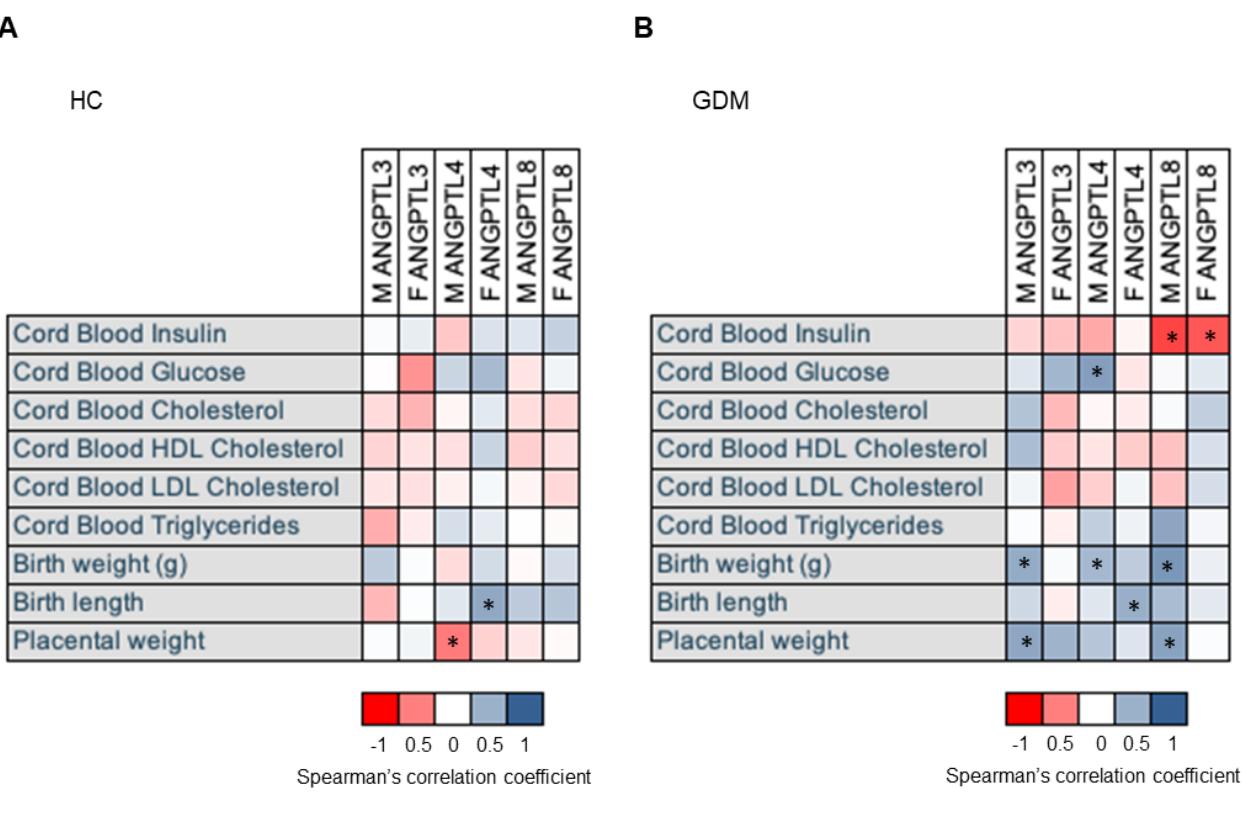
Figure 3. ANGPTL expression is associated with offspring parameters in the GDM group. Heatmap of the correlation coefficients observed between ANGPTL3, 4 , and 8 placental expressions and neonatal clinical variables in control ( A ) and GDM ( B ) mothers. Gene expression data are expressed as fold change. Correlations were calculated using Spearman’s correlation coefficient. * p < 0.05. HC: healthy control; GDM: gestational diabetes mellitus; M before the name of any gene expression indicates expression on the maternal side of the placenta; F before the name of any gene expression indicates expression on the fetal side of the placenta. ANGPTL3: Angiopoietin-Like Protein 3; ANGPTL4: Human Angiopoietin-Like Protein 4; ANGPTL8: Human Angiopoietin-Like Protein 8. When the same analysis was performed on gestations complicated with GDM, some differences were observed. ANGPTL4 , in addition to the associations observed in normal gestation, showed a positive relationship with FABP3 and SLC27A4 on the maternal side of the placenta and with LPL on the fetal side of it. The associations of ANGPTL8 were maintained, except with LPL , which was lost. By contrast, a change in the association pattern of ANGPTL3 was observed. The associations observed with fetal ANGPTL3 were lost. Instead, maternal ANGPTL3 showed a positive association with CPT1A and CPT1B expressions on the maternal side and with maternal SLC27A4 (see Figure